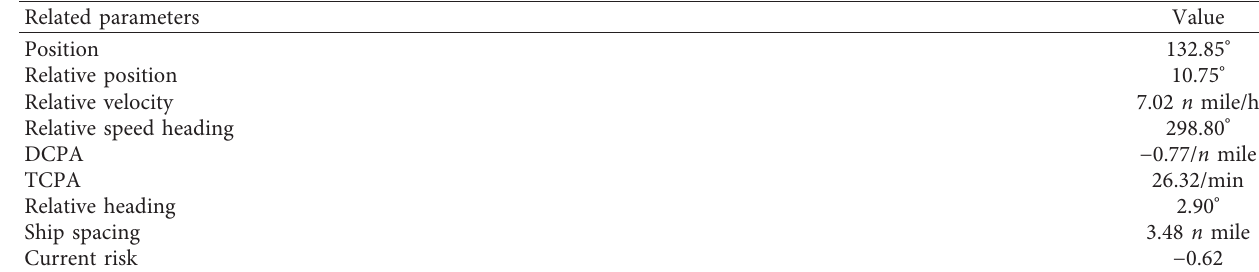
Figure 29: The hazard curve of ship collision avoidance described in this scene. Table 3: Relevant data of chase scene